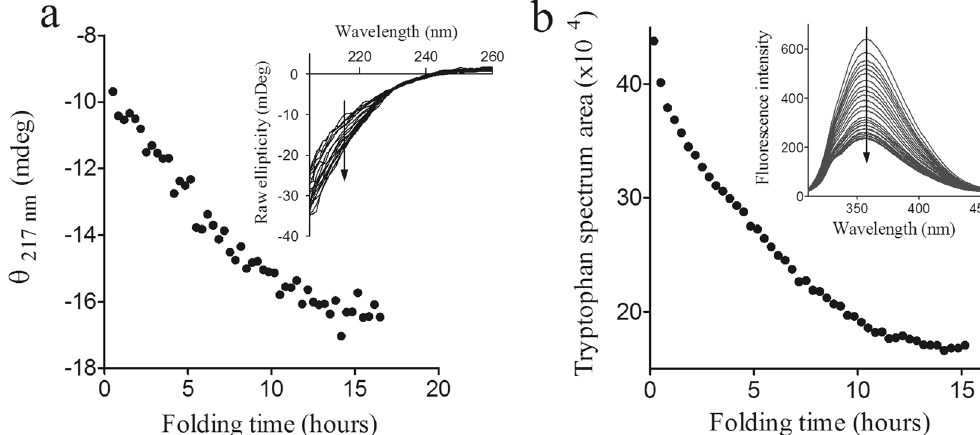
Figure 3. Secondary and tertiary structural changes upon oxidative folding of NvCI. The secondary and tertiary structure changes along folding time were monitored by far-UV CD and tryptophan fluorescence spectra measurements, respectively. The fully reduced/unfolded protein was allowed to refold in 0.1 M Tris- HCl pH 8.4 at 20 °C. ( a ) Plot of ellipticity at 217 nm as a function of folding time. Inset: Far-UV CD spectra at different time points along folding. ( b ) Tryptophan spectrum area changes as a function of folding time. Inset: Tryptophan fluorescence spectra at different time points along folding. The arrow indicates the progression of the folding reaction along